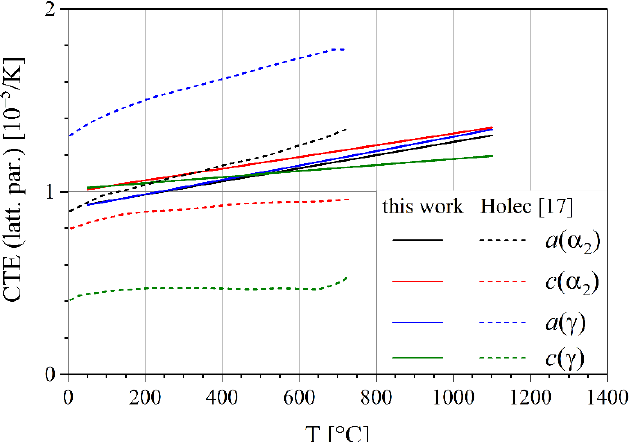
Figure 12. Comparison of linear coefficients of thermal expansion of the crystal lattice during heating (this work) and the work of Holec et al. [19]. The data of Holec et al., which stem from atomistic modelling, were extracted from